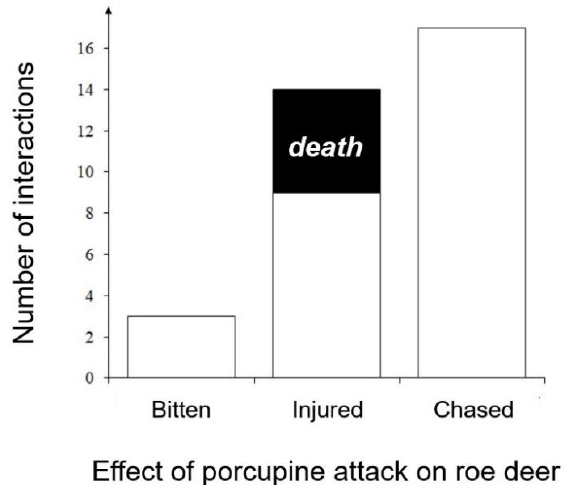
Figure 1. Aggressive interactions between crested porcupine and roe deer.